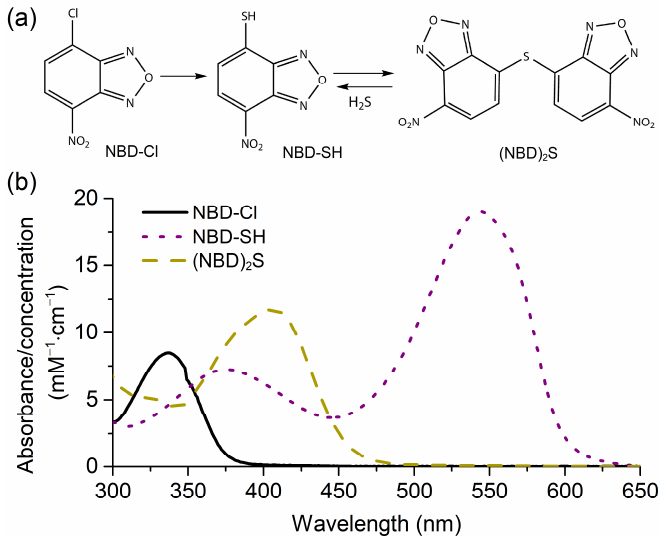
Figure 1. ( a ) Chemical reaction pathway of NBD derivatives involved in the sensing mechanism, namely NBD-Cl, NBD-SH and (NBD) 2 S. ( b ) UV − Vis spectra of NBD-Cl, NBD-SH and (NBD) 2 S in diluted methanol